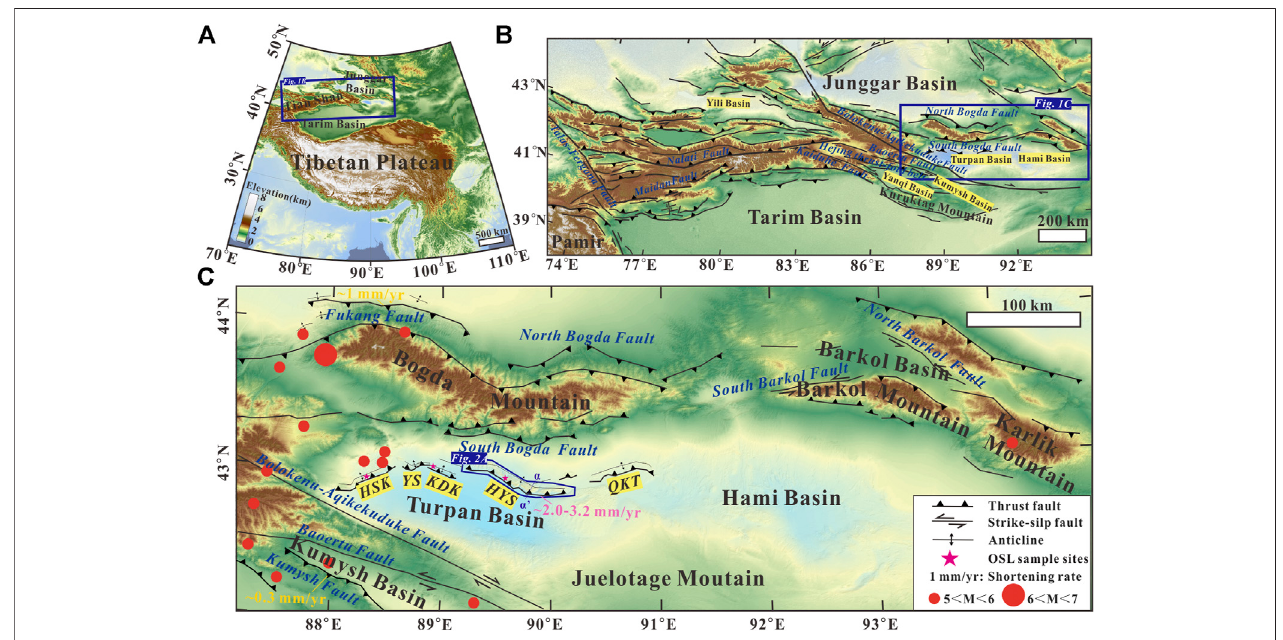
FIGURE1|(A) TopographyoftheTibetanPlateauinresponsetotheIndia-Eurasiacollision. (B) TopographyandmajoractivefaultsintheTianShan(see Figure1A for the location). (C) Topography and major active faults in the Eastern Chinese Tian Shan (see Figure 1B for the location). Fault data are from Deng et al., 2000; Shen et al., 2003; and Wu et al., 2016; red dots indicate earthquakes ( M > 5) from 1900-01 to 2020-11 (downloaded from the United States Geological Survey at https:// earthquake.usgs.gov/);shorteningratesinyellowfontin Figure1C arefromWuetal.,2016andWangetal.,2020a;andthoseinpinkfontarefromthisstudy;HSK, Hongshankou structure; YS, Yanshan structure; KDK, Kendeke structure; HYS, Huoyanshan structure; QKT, Qiketai structure.